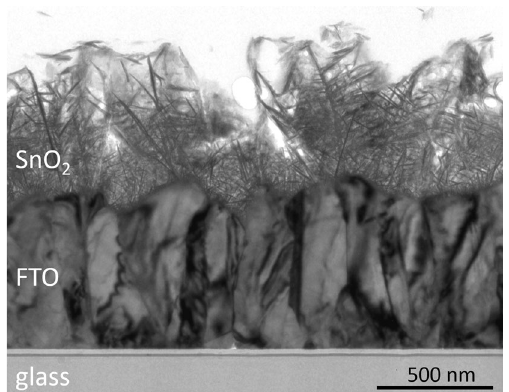
Figure 7. Cross-sectional TEM image of the SnO 2 (101) nanosheet assembled film.